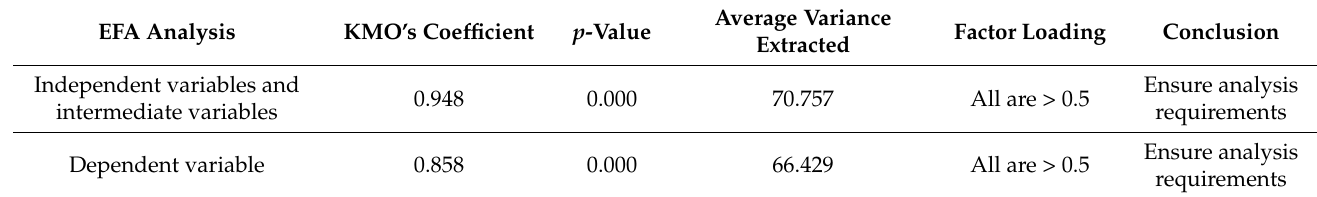
Table 3. Result of exploratory factor analysis